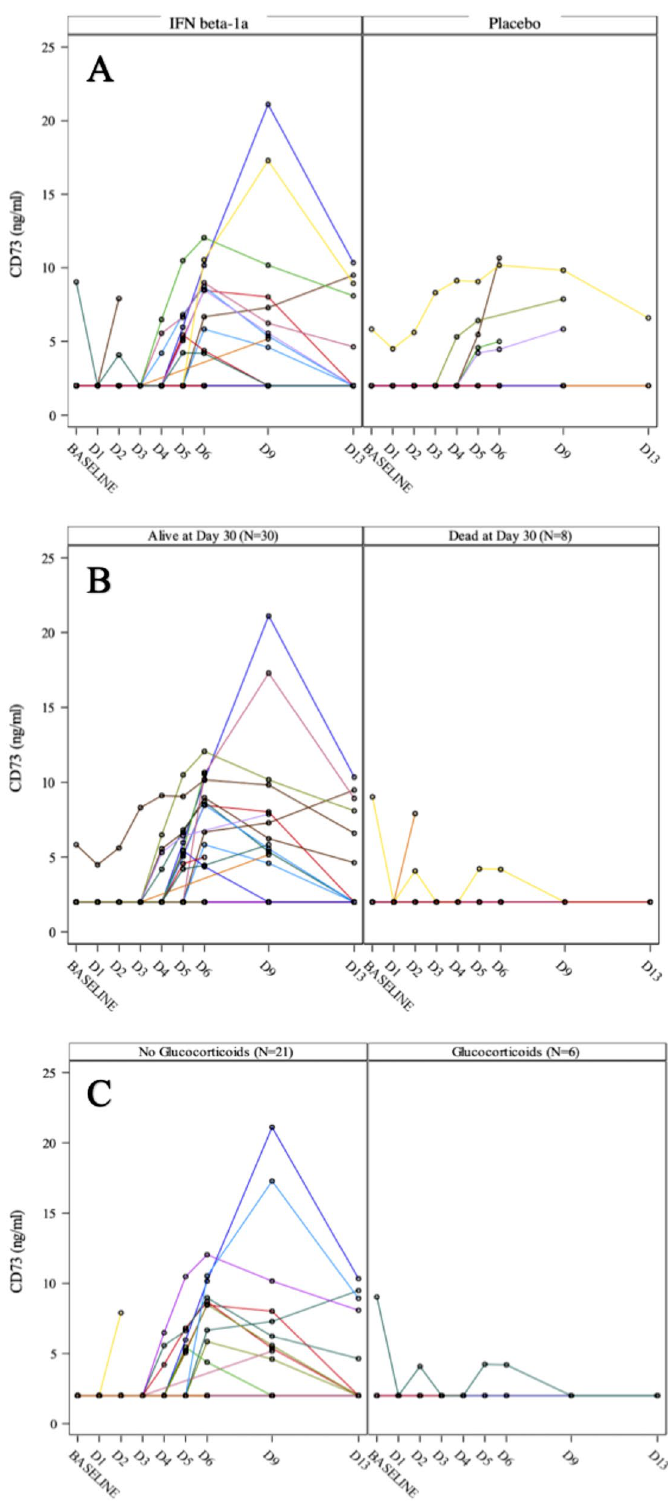
Figure 2. Individual CD73 responses ( A ) in the active vs. placebo arms (no significant difference), ( B ) in patients that survived vs. patients that died by D30 (i.e. all study patients), mean max CD73 achieved between groups 6.09 ng/mL (SD, 4.95 ng/mL) correspondingly for patient without glucocorticoids vs. 2.37 ng/mL (SD, 0.90 ng/mL) (Satterthwaite t-test, P < 0.001), and ( C ) in patients that received vs. did not receive overlapping glucocorticoids with IV IFN beta-1a (i.e. active arm only), mean max CD73 achieved between groups 6.52 ng/ mL (SD, 5.37 ng/mL) for patient without glucocorticoids vs. with glucocorticoids 2.37 ng/mL (SD, 0.91 ng/mL) (Satterthwaite t-test, P =